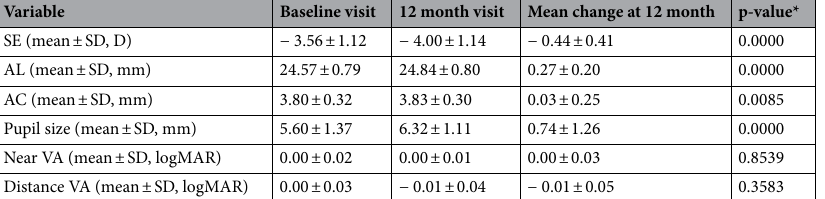
Table 2. Changes in ophthalmic parameters after one-year atropine 0.01% treatment. *t Student and Wilcoxon test paired samples. SE Spherical Equivalent, SD standard deviation, D diopter, AL Axial length, AC Anterior chamber, VA Visual acuity, logMAR logarithm of minimum angle